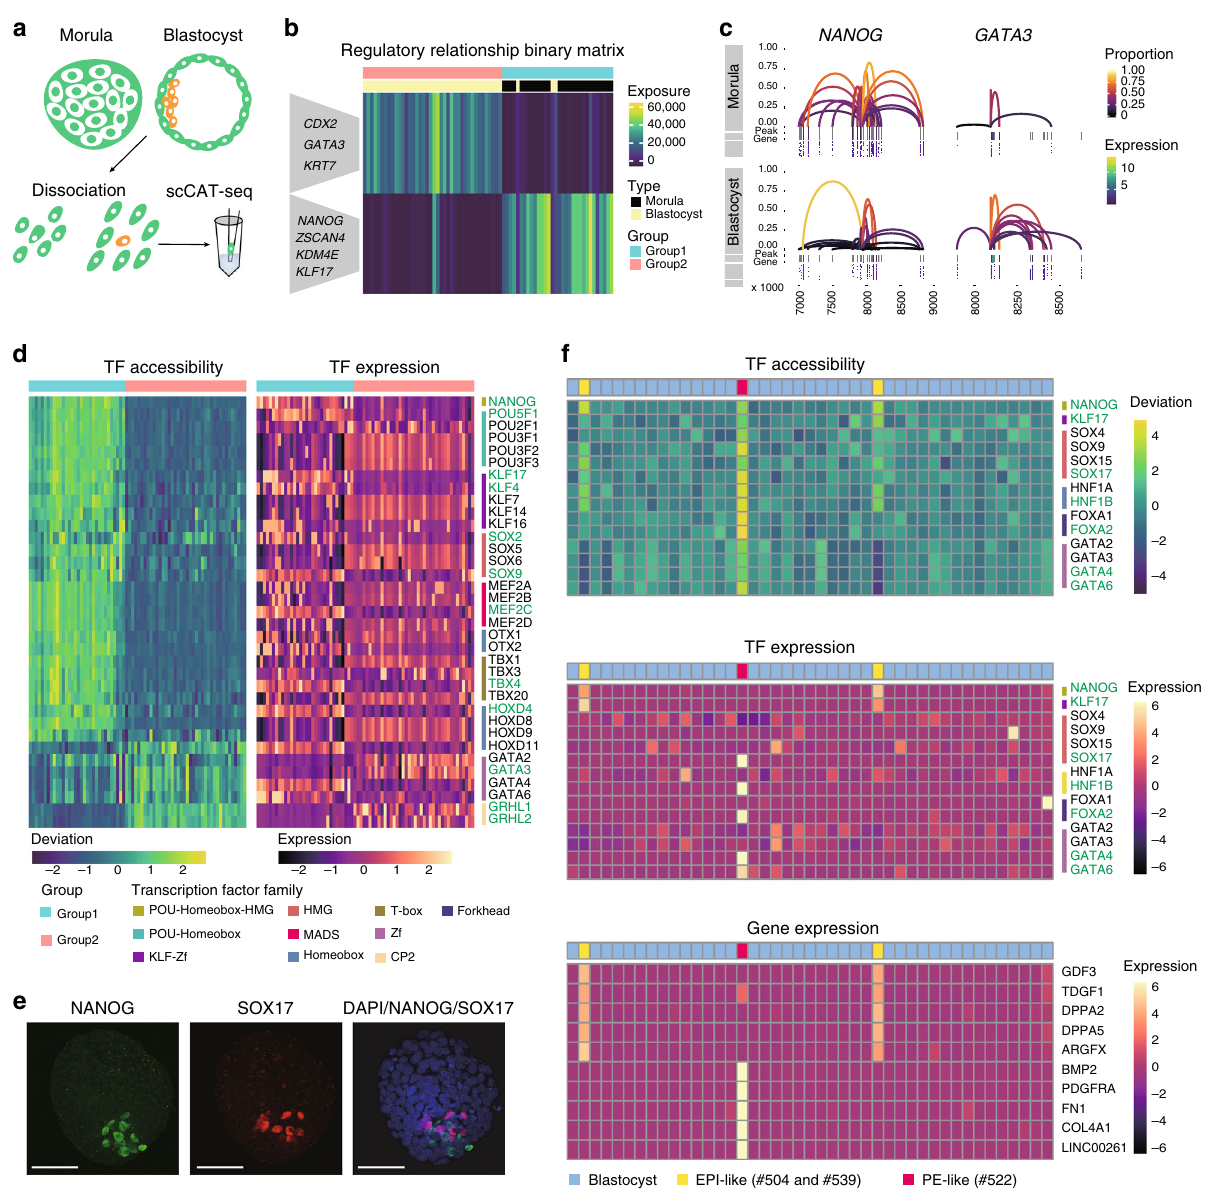
Fig. 3 scCAT-seq enables precise characterization of single-cell identities in human pre-implantation embryos. a A work fl ow showing the generation of scCAT-seq pro fi les of human pre-implantation embryos. b Heatmap showing exposure scores of all cells to each signature identi fi ed by the NMF clustering of regulatory relationship binary matrix of human embryos. Example genes are shown. c Regulatory relationships for the indicated genes in single cells of the morula and blastocyst stage. d Heatmaps showing accessibility deviation (left) and expression level (right) of the indicated TFs. The TFs colored in green were the ones showing consistent patterns in accessibility and gene expression. e Immuno fl uorescence imaging of the human blastocyst stage embryo using the indicated antibodies (left to right: NANOG, SOX17 and merged DAPI/NANOG/SOX17). Scale bar represents 50 μ m. f Top and middle panels: Heatmaps showing the accessibility deviation (top) and expression level (middle) of the indicated TFs in single cells of blastocyst-stage embryos. Bottom panel: heatmap showing the expression level of the indicated genes. The TFs coloured in green were the ones showing consistent patterns